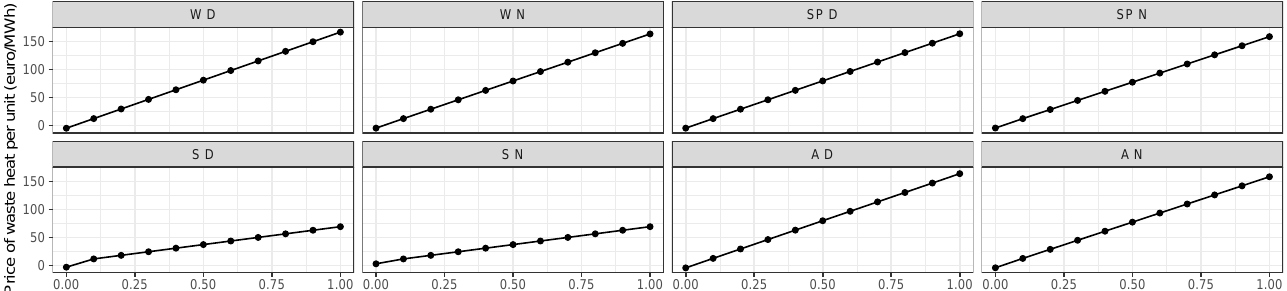
Figure 1. Price per unit of waste heat Pw as a function of α for each time segment.